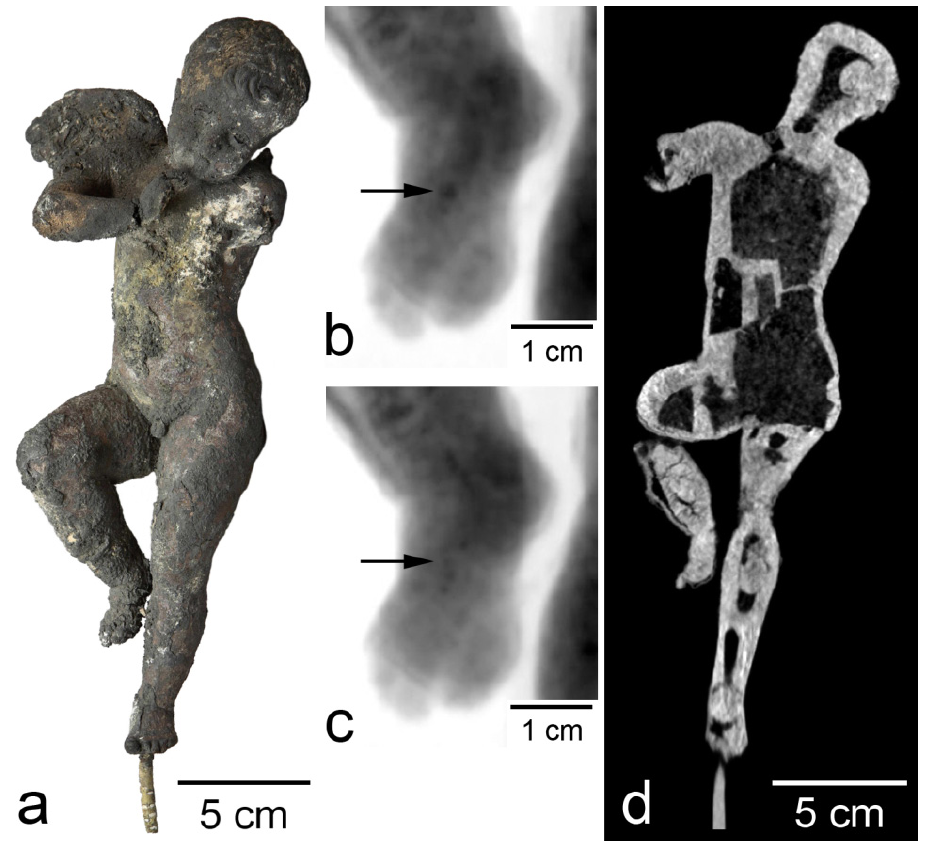
Figure 4. Study of “Dancing Cupid” statuette: ( a ) photograph of the figurine; ( b , c ) neutron projections of a fragment of the statuette, obtained with a rotation of 2° (the arrow points to one of the grains); ( d ) tomographic slice.